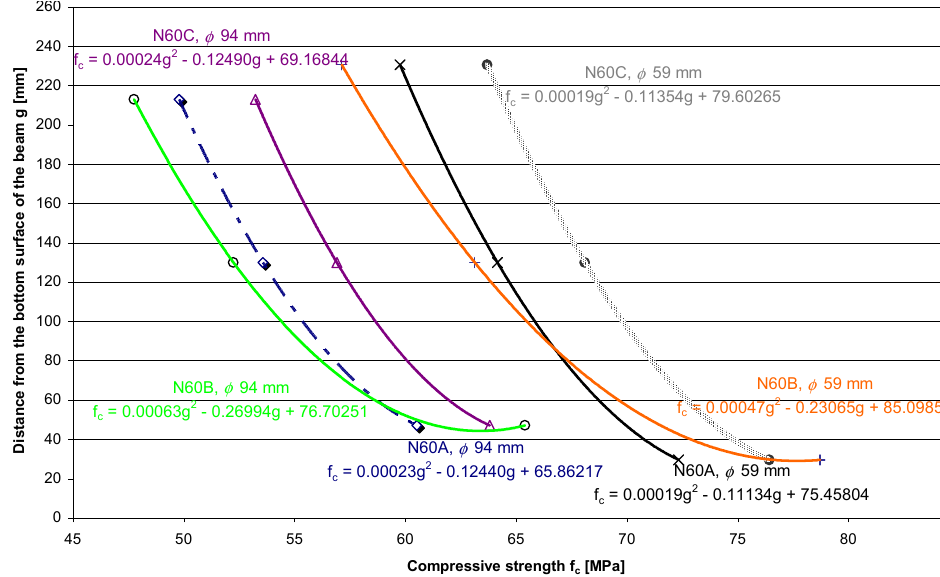
Figure 7. Distribution of the compressive strength of the 60 MPa concrete, which was determined across the height of the core samples with diameters of 59 mm and 94 mm.